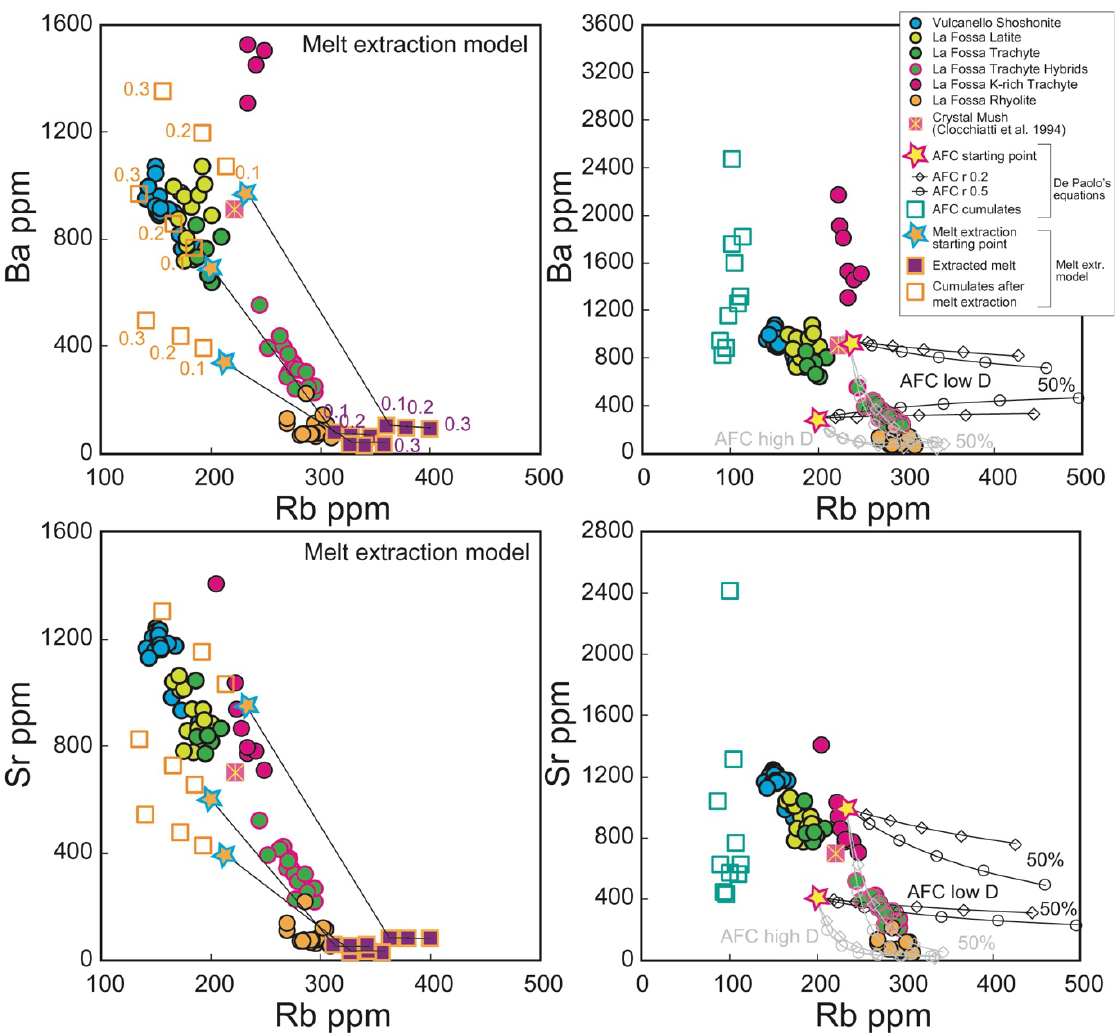
Figure 7: Trace element modelling of rhyolitic melt extraction (left panels) using the model of [15] and comparison with simple AFC modelling obtained with the equations of [56] (right panels). Numbers along the extracted melts and calculated leftover cumulates composition after melt extraction refer to the fraction of extracted melt (0.1–0.3) (see Supplementary Table S8 for results of the model). It is worth noting that the cumulate compositions left over by melt extraction compare well with the latitic crystal-rich enclaves occurring in the La Fossa rhyolites with respect to the cumulates compositions calculated with the models of [56] (see text). Literature data sources as in Figure 2.